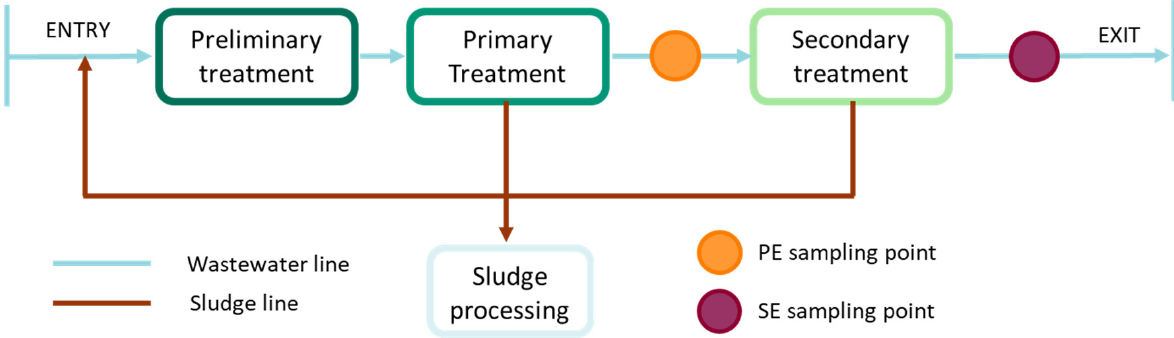
Figure 1. Scheme of the treatment process and effluent sampling points in the WWTP selected for this study.